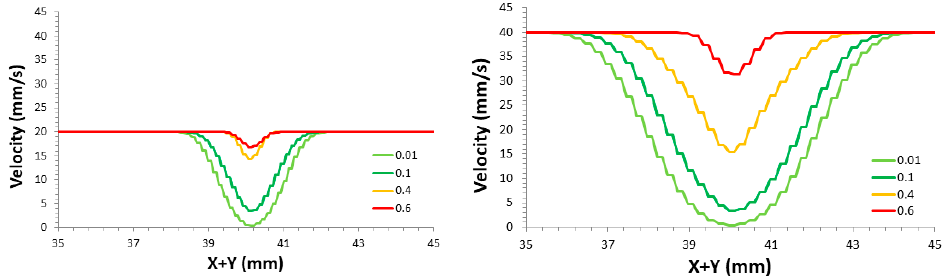
Figure 7. Speed recording as a function of position on each axis in the vicinity of the corner. v = 20 mm/s ( left ) and v = 40 mm/s ( right